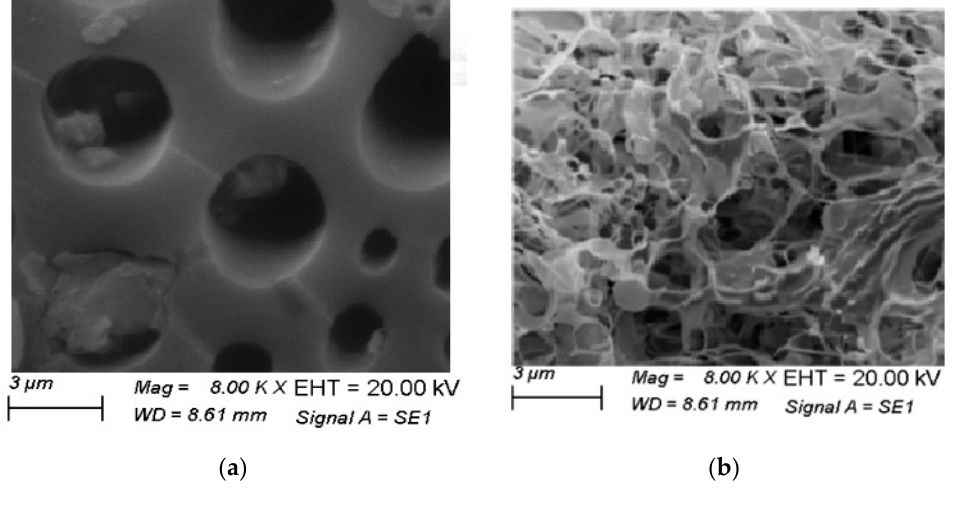
Figure 5. SEM morphology of ( a ) BC, ( b ) IPNCB.